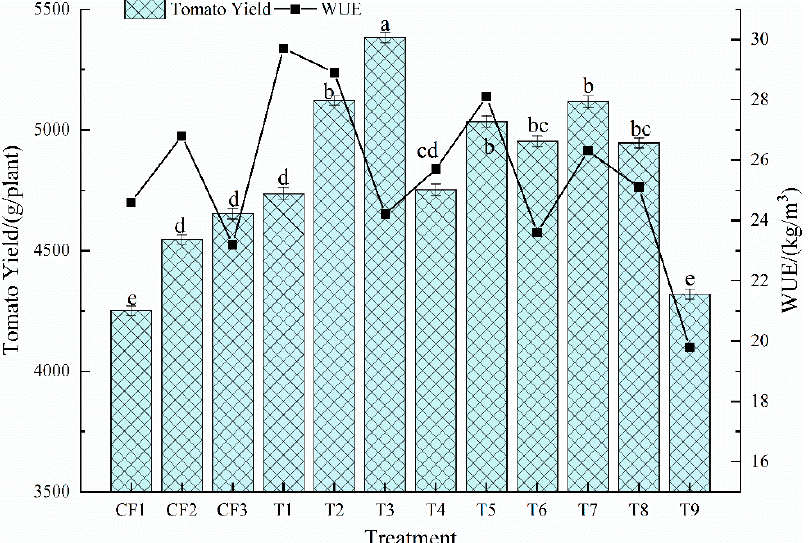
Figure 4. Effects of different biogas slurry proportions and irrigation rates on tomato yield and water use efficiency. Different lowercase letters a–e indicate significant differences between treatments.